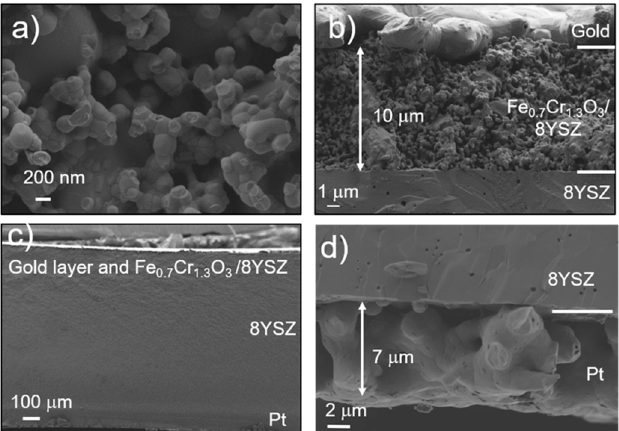
Figure 3. SEM image of the device cross-section corresponding to FeCr 2 O 4 /8YSZ as WE and Pt as RE. ( a ) WE electrode cross-section with FeCr 2 O 4 and 8YSZ grains. ( b ) Interface WE-electrolyte where a good attachment of the layer can be observed. Gold collector layer at the top as well as FeCr 2 O 4 and 8YSZ grain distribution can be observed. ( c ) Complete device FeCr 2 O 4 /8YSZ//8YSZ//Pt can be observed. ( d ) Sintered platinum reference can be observed.